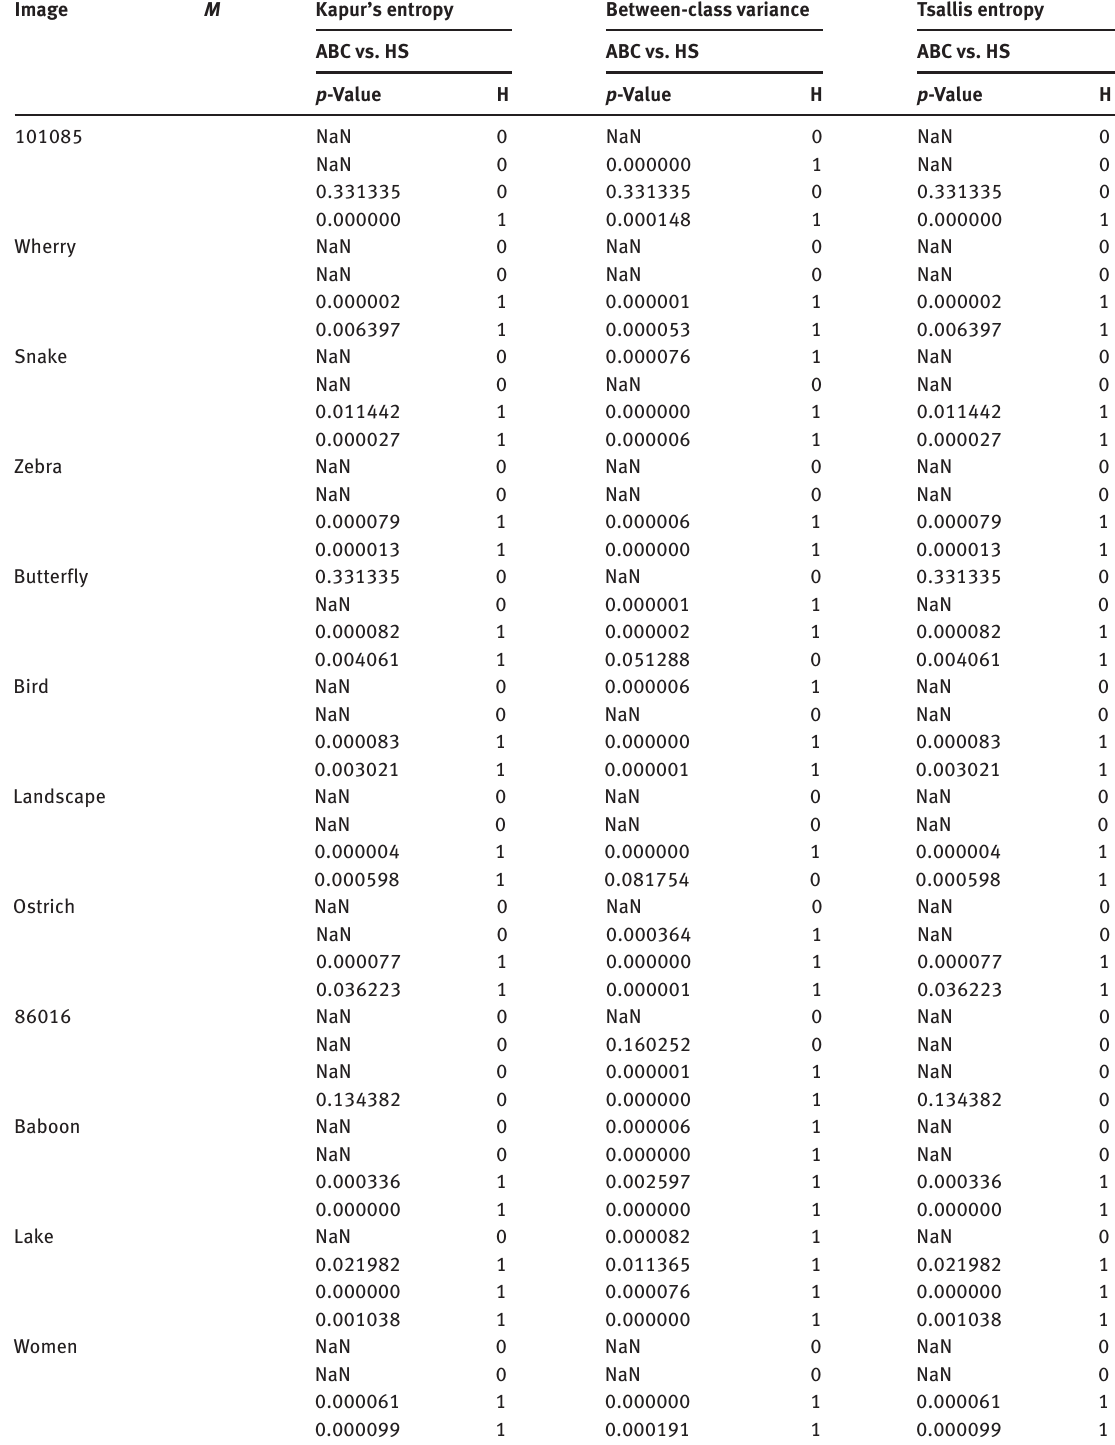
Table 13: Statistical Analysis of 35 Runs for each of 12*4 Cases for the Experiments on each Criterion. Image